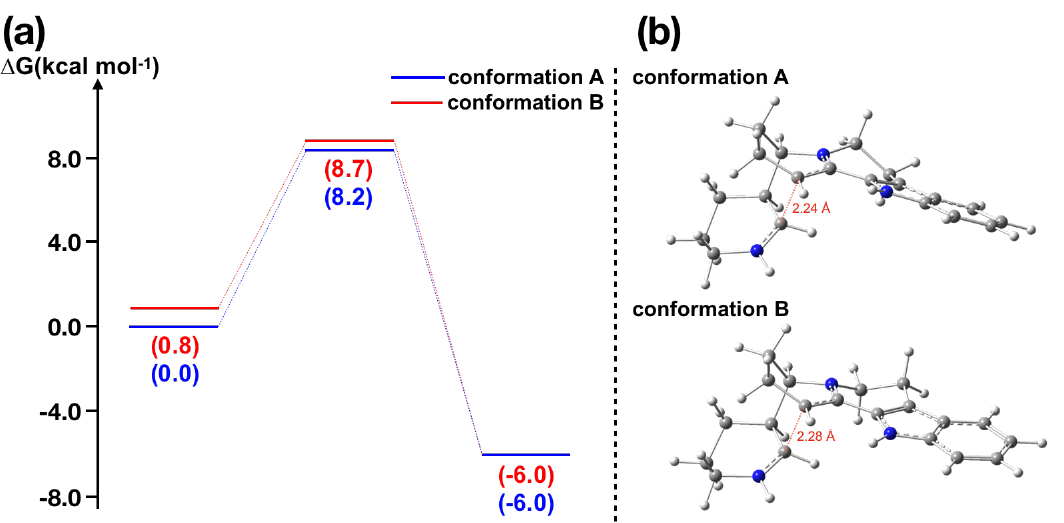
Figure 3. Calculation results of piperideine dimerization-type reaction in nitramidine biosynthesis: ( a ) energy diagram for the nitramidine dimerization-like reaction; and ( b ) transition state structures of nitramidine dimerization-like reaction for two